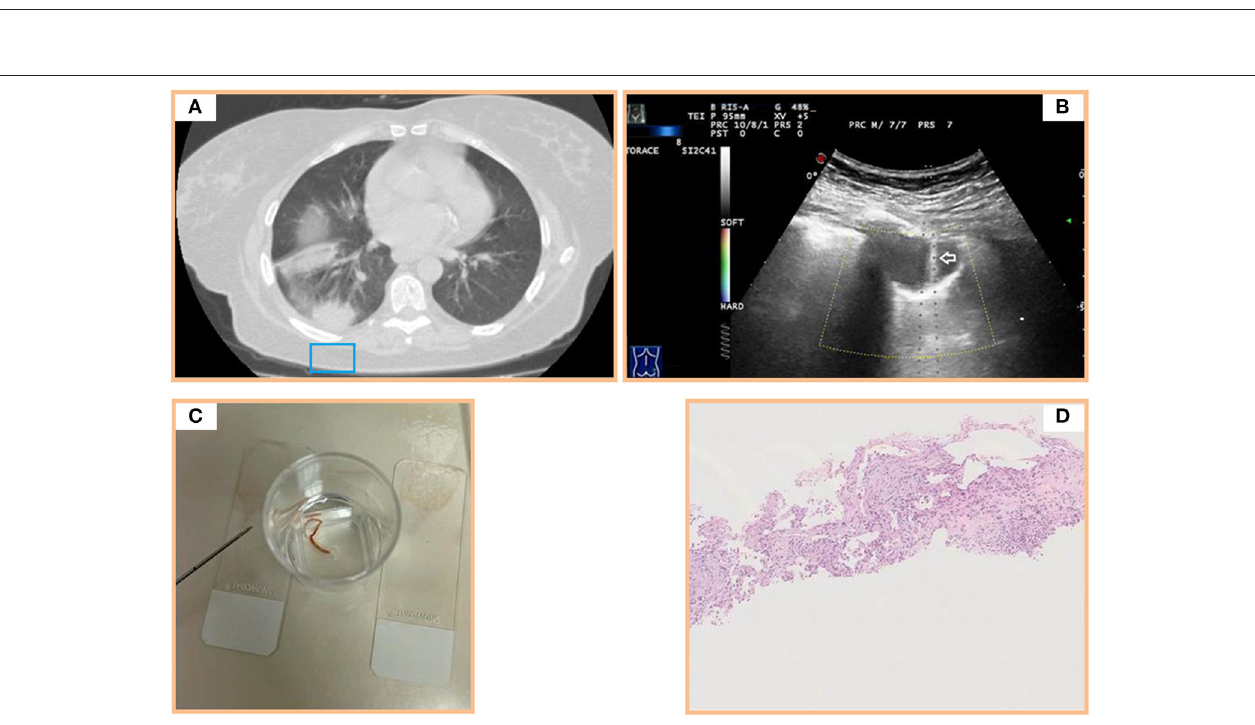
FIGURE 3 | (A) Axial chest computed tomography (CT) of multiple subpleural pulmonary consolidations in the lower right lobe. (B) Transthoracic ultrasound scan (TUS) using the dedicated convex probe (3.5–8 MHz) during US-guided biopsy (corresponding to the blue box in A) allowing real-time visualization of the needle (white arrow) in the posterior hypoechoic subpleural lung lesion. (C) Specimen suitable for histologic and cytologic diagnosis. (D) Histological examination of a sample from the posterior subpleural consolidation (hematoxylin and eosin) showing thickened alveolar septa with inflammatory infiltrate and fibroblastic plugs in alveolar sacs.